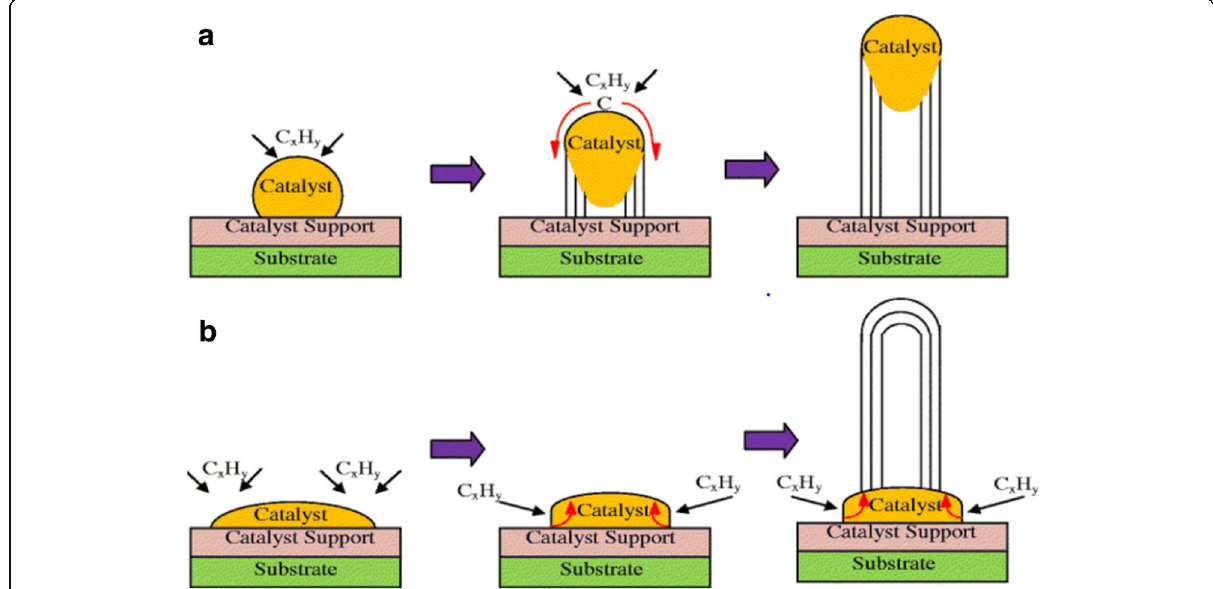
Fig. 7 Different growth mechanisms of CNTs using CVD (Adapted from [101]). Based on the catalyst-substrate interactions, two types of CNT growth mechanics can be seen. a Tip-growth model: with weak catalyst-substrate interactions, a tip-growth is observed where hydrocarbon decomposes on top surface of the metal that causes carbon to diffuse downwards through the metal leading to CNTs growing out from the bottom of the metal. b Base- growth model: With strong catalyst-substrate interactions, a base-growth is observed where CNTs grow out of the metal far from the substrate while the catalyst is rooted at the